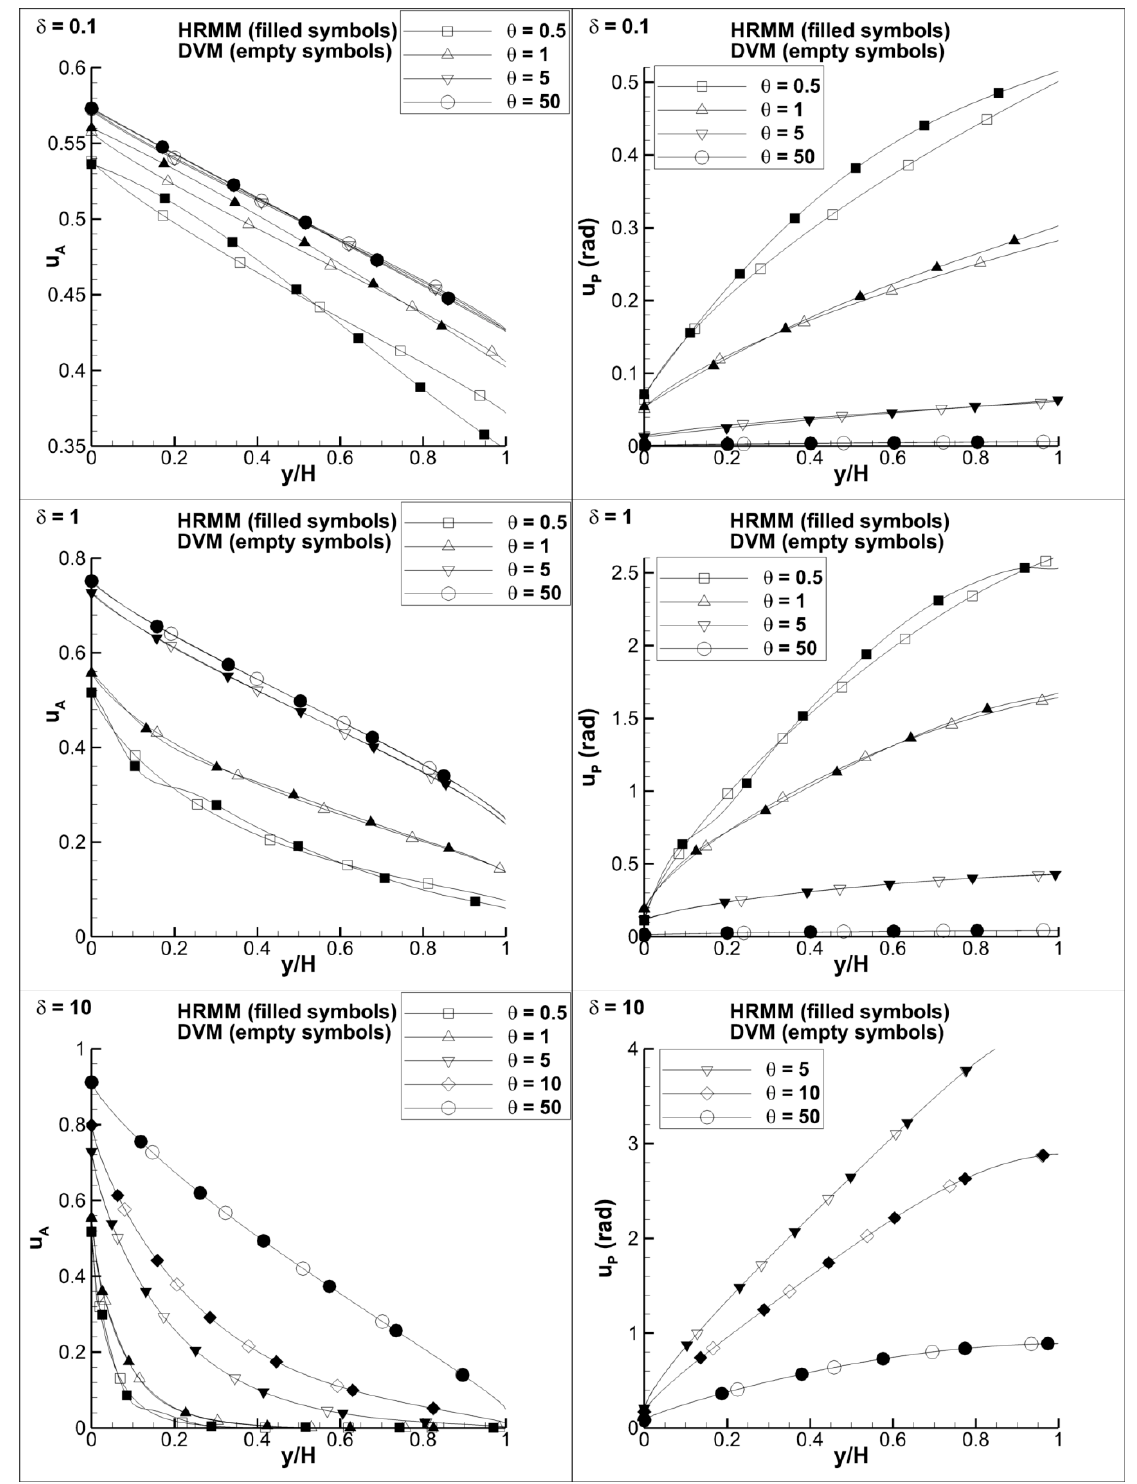
Figure 2. Oscillatory Couette flow; comparison between the distributions of velocity amplitudes and phases obtained by HRMM ( N = 5) and the DVM for various values of the oscillation and gas rarefaction parameters. Table 4. Oscillatory Couette flow; shear stress amplitude at the oscillating wall various values of δ and θ based on the HRMM, with 1,3,5 N = and the DVM, along with the relative difference between corresponding results.